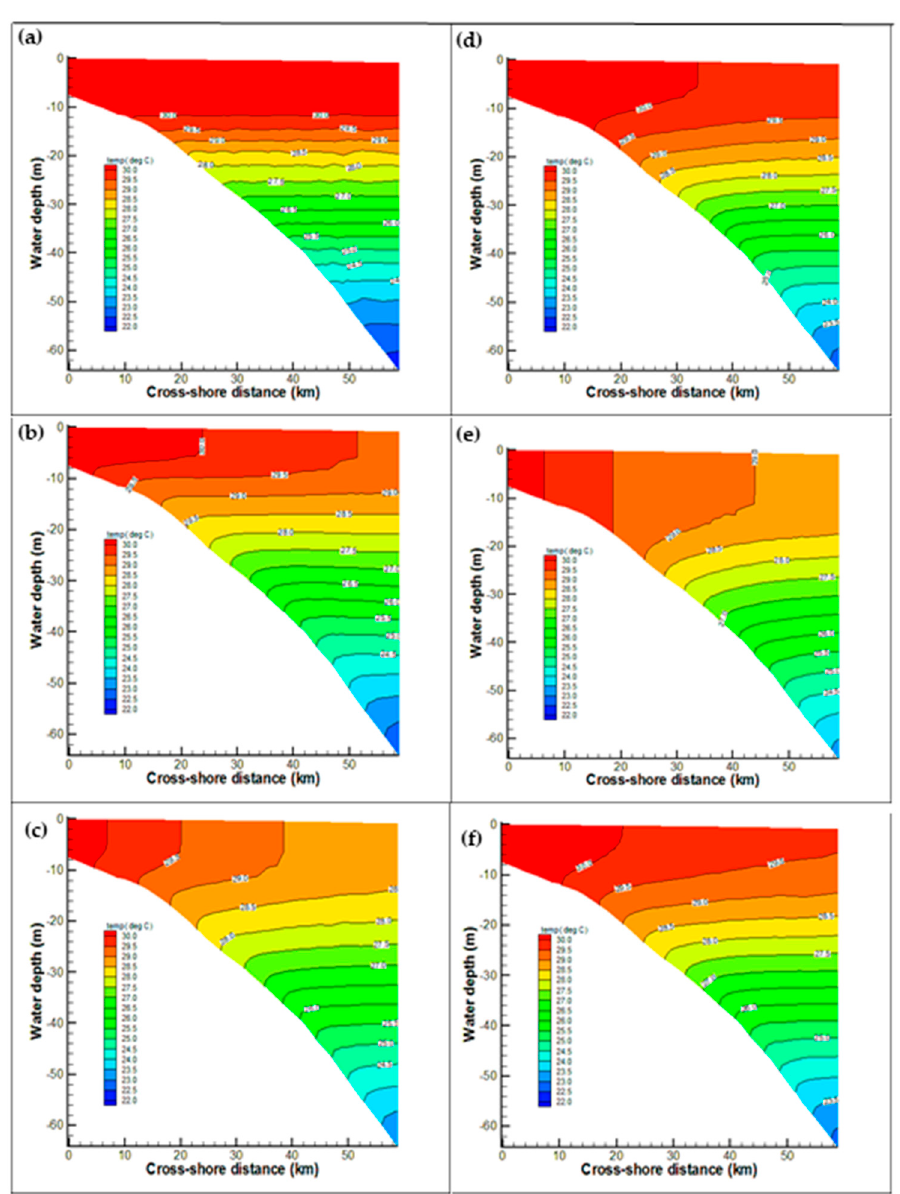
Figure 11. Distribution of simulated temperature across transect A (Figure 1 for location) ( a ) 1 October, ( b ) 10 October, ( c ) 17 October, ( d ) 22 October, ( e ) 27 October, ( f ) 1-month average.